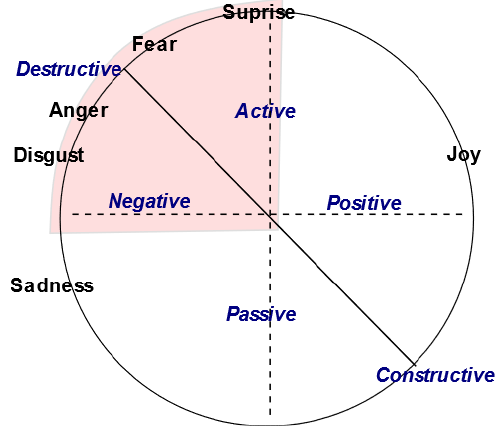
Fig. 2. Emotional state distribution in 2D space. The area containing potentially dangerous emotions is marked in red. [25], which is higher than the human accuracy estimated in